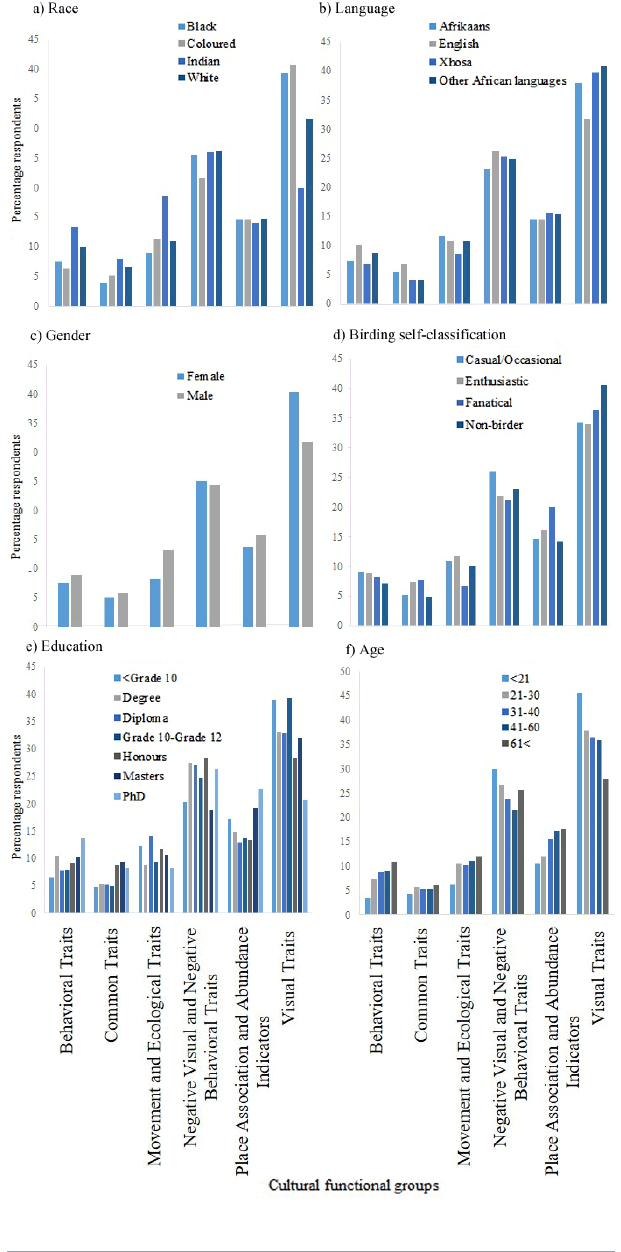
Fig. 2 . Percentage distribution of socio-demographic characteristics between dimensions of cultural functional groups: (a) race, (b) language, (c) gender, (d) birding self- classification, (e) education, and (f) age.